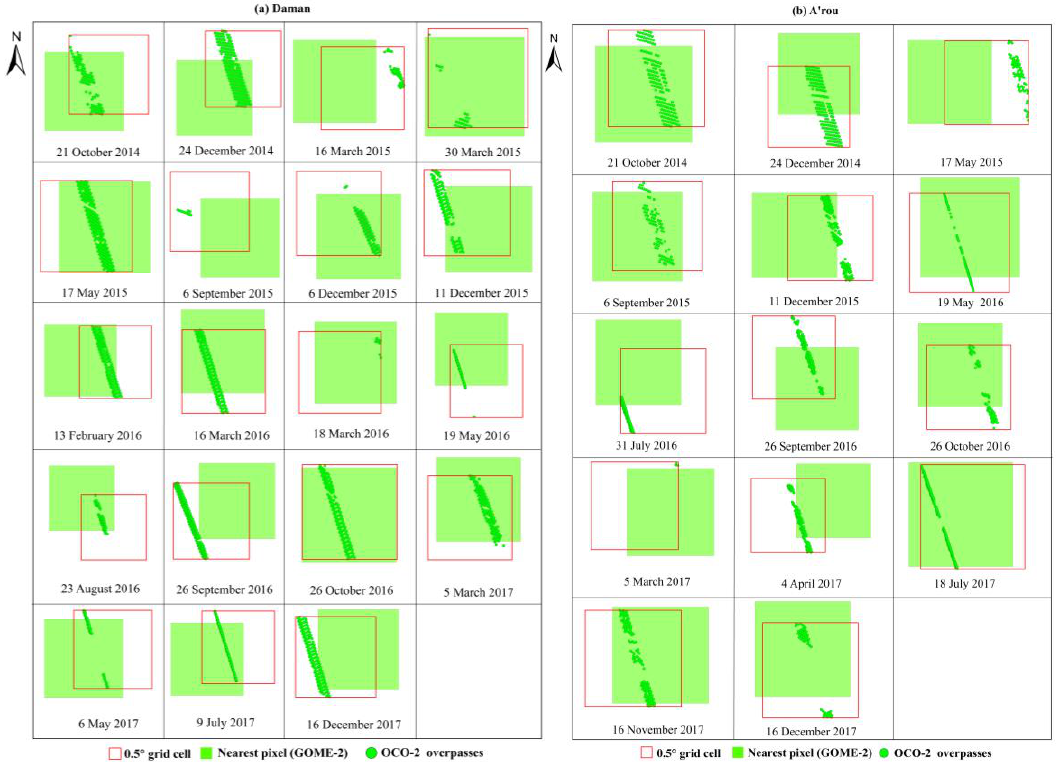
Figure 6. Availability of OCO-2 overpasses and nearest GOME-2 SIF pixels within the 0.5° grid cell on the corresponding date at the (a) Daman and (b) A’rou sites.